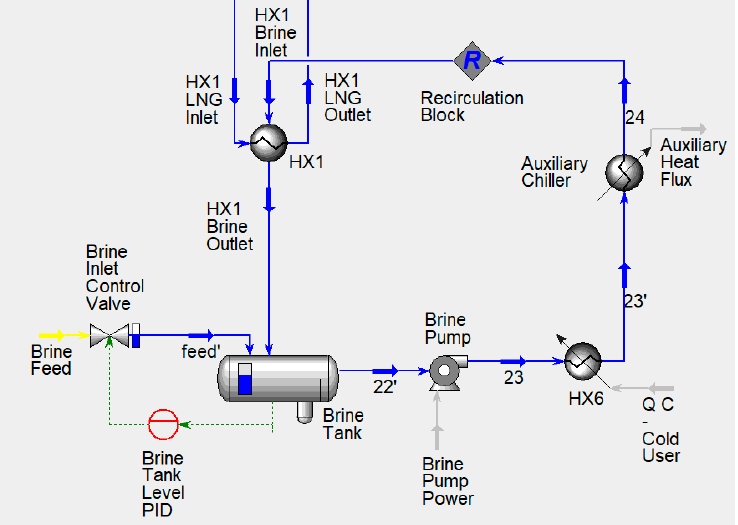
Figure 2. Secondary Brine Loop Configuration (UNISIM model).